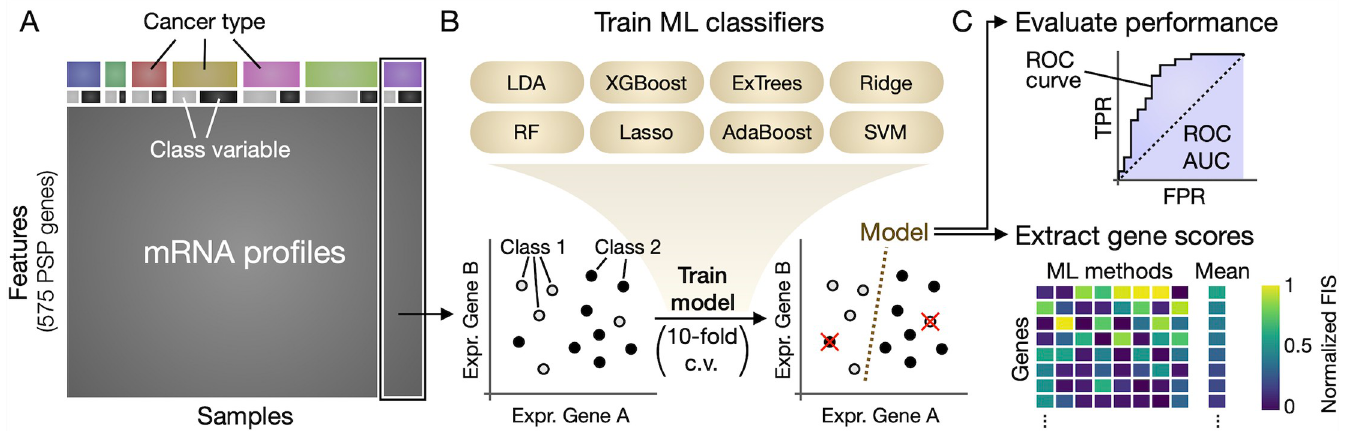
Fig 1. Schematic of the ML gene scoring approach. ( A ) RNA-Seq data from TCGA was filtered to remove non-PSP genes, and cancer types were analyzed individually. ( B ) Samples within each cancer type were grouped according to a binary variable (e.g., Class 1 = normal; Class 2 = tumor), and 8 different ML algorithms were used to train models to predict sample class based on PSP gene expression levels (red Xs in the plot indicate failed predictions). ( C ) The prediction performance of each model was evaluated by ROC AUC, and the feature (gene) importance scores were extracted from each ML model, normalized to a range of 0–1, and averaged across all ML algorithms to obtain a consensus ML gene score. Abbreviations: c.v., cross-validation; TPR, true positive rate; FPR, false positive rate; FIS, feature importance score.